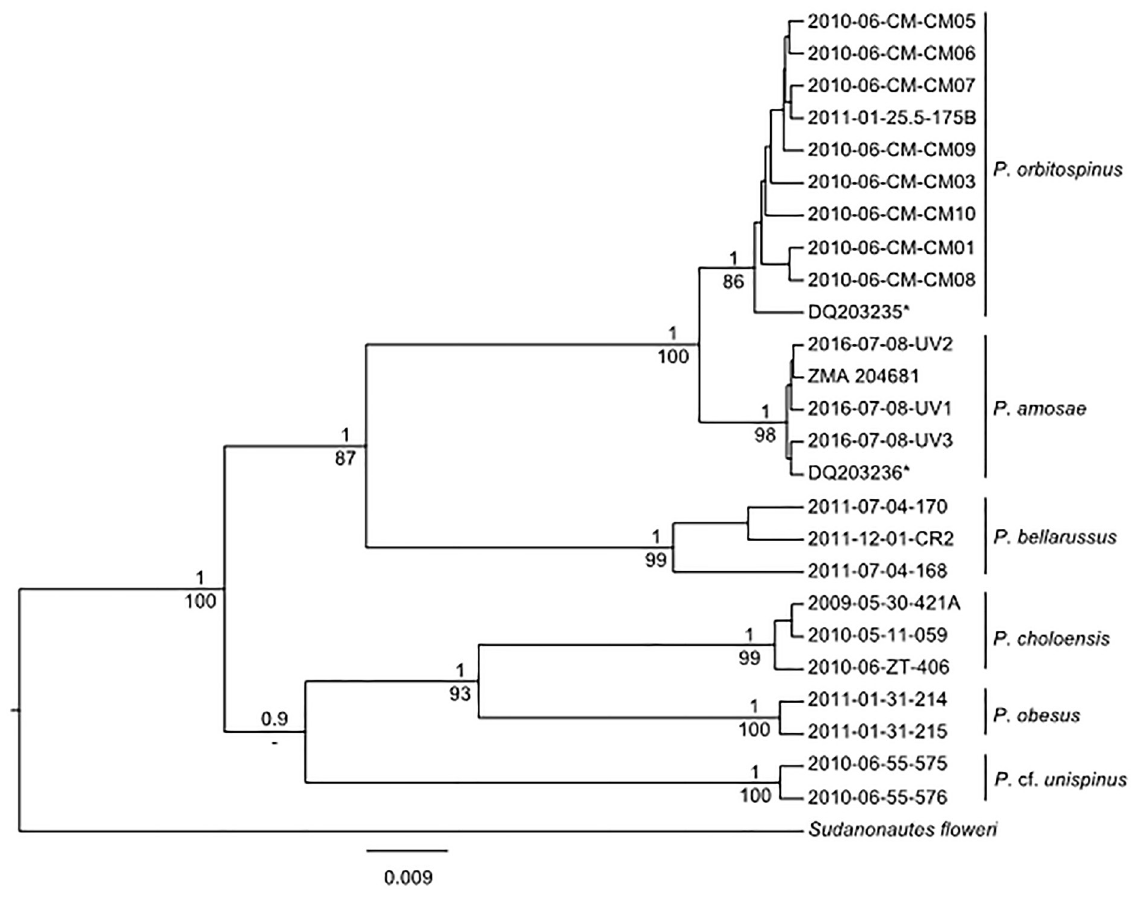
Fig. 14. Phylogenetic relationships of species of African freshwater crabs included in the present study. Potamonautes orbitospinus (Cunnington, 1907) and P. amosae sp. nov. were both formerly included in the Potamonautes lirrangensis (Rathbun, 1904) s. lat. species complex. The analysis combines 16SrRNA (489 bp alignment) and Histone 3 sequences (290 bp alignment). Numbers above